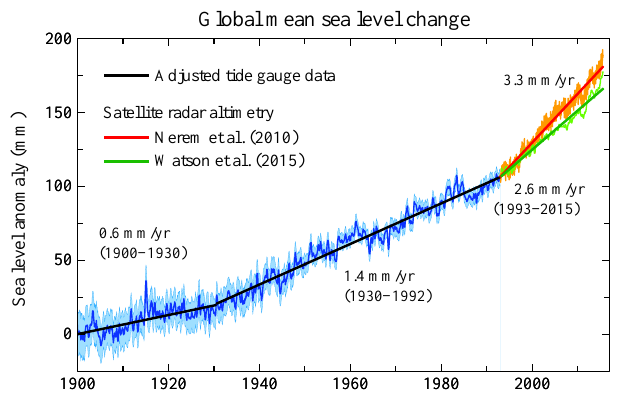
Figure 29. Estimated sea level change (mm) since 1900. Data through 1992 are the tide-gauge record of Church and White (2011) with the change rate multiplied by 0.78, so as to yield a mean 1901– 1990 change rate of 1.2mmyear − 1 (Hay et al., 2015). The two esti- mates for the satellite era (1993–2015) are from Nerem et al. (2010, updated at http://sealevel.colorado.edu) and Watson et al. (2015).